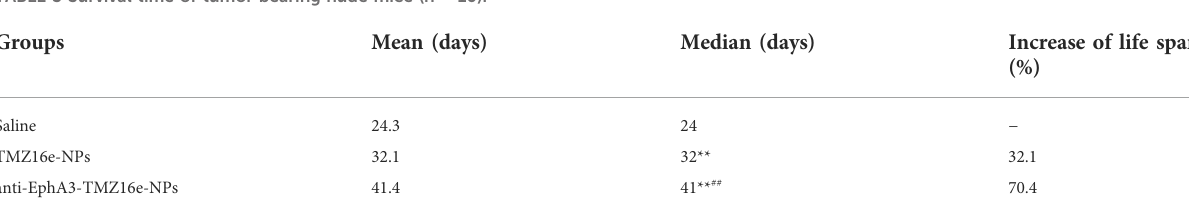
TABLE 3 Survival time of tumor bearing nude mice (n = 10).